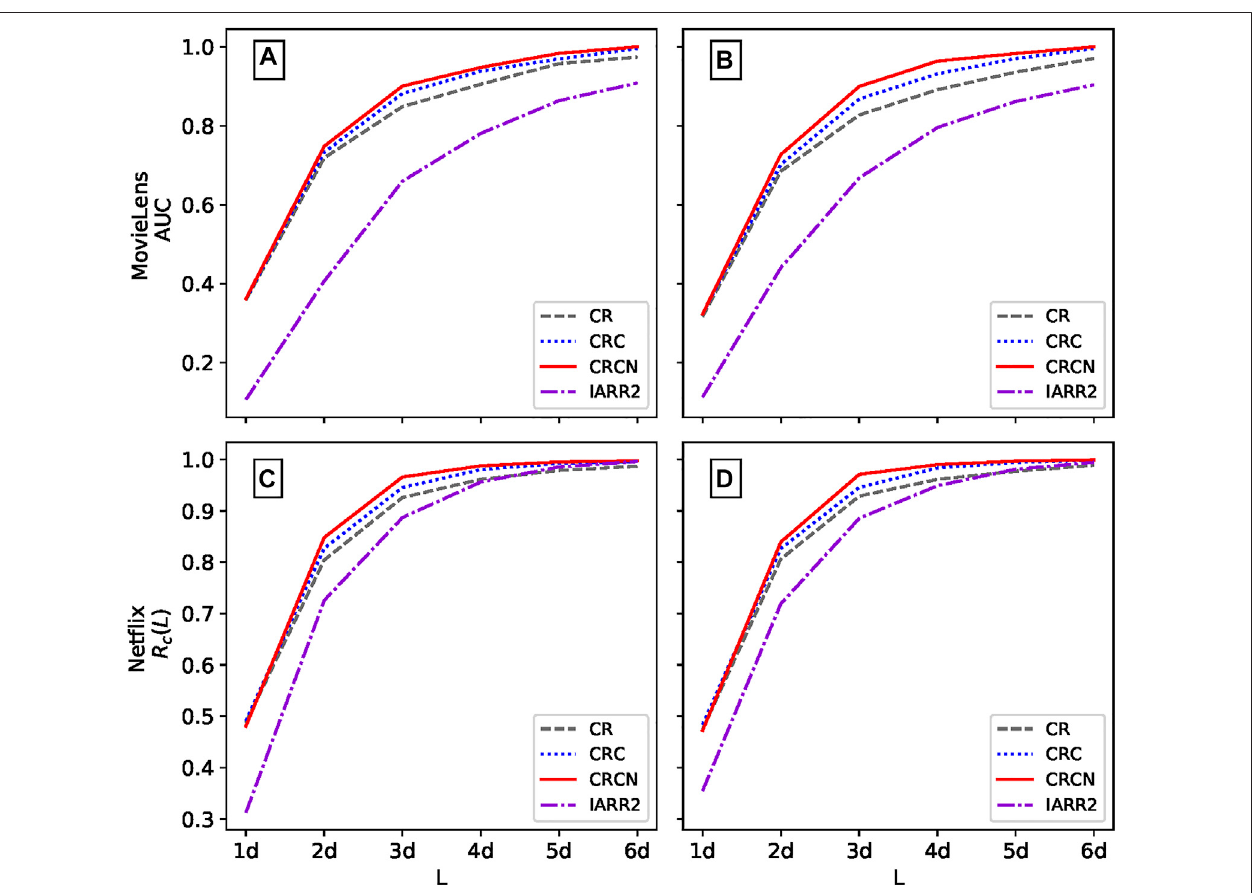
FIGURE 3| The recall score R c of different methodsvaries withlength L in MovieLens and Net fl ix. Panels (A) and (C) represent random spammers, and panels (B) and (D) represent malicious spammers. The parameter ρ in both datasets is 0.05, and the parameter ω is 0.05 and 0.01 for MovieLens and Net fl ix, respectively. The results are averaged over ten independent realizations.